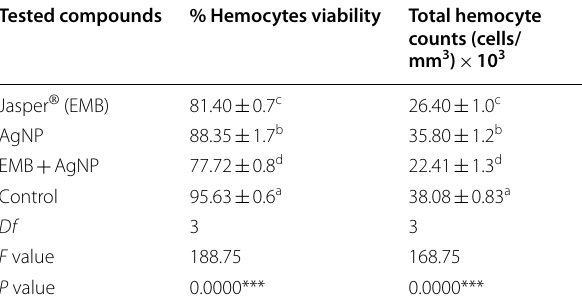
Means followed by the same letter in a column are not significantly different at the 5% level of probability (Duncan’s Multiple Range Test) [14]